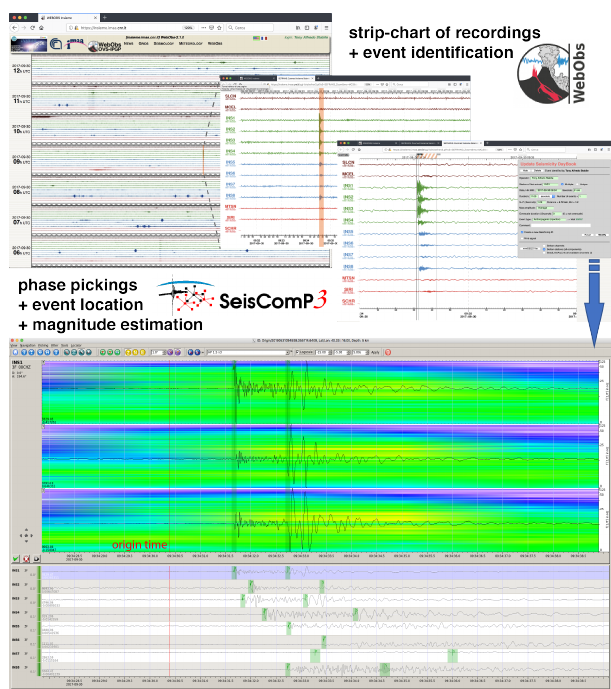
Figure 6. Tools implemented for visualization and processing of acquired seismic data. The WebObs system (top panels) is used to plot a strip chart of recordings at configured stations in near real time for any event present in the data. When an event is identified, the information is sent to the SeisComP3 database for the manual phase picking and event location (bottom panel) through the Origin Locator Viewer tool